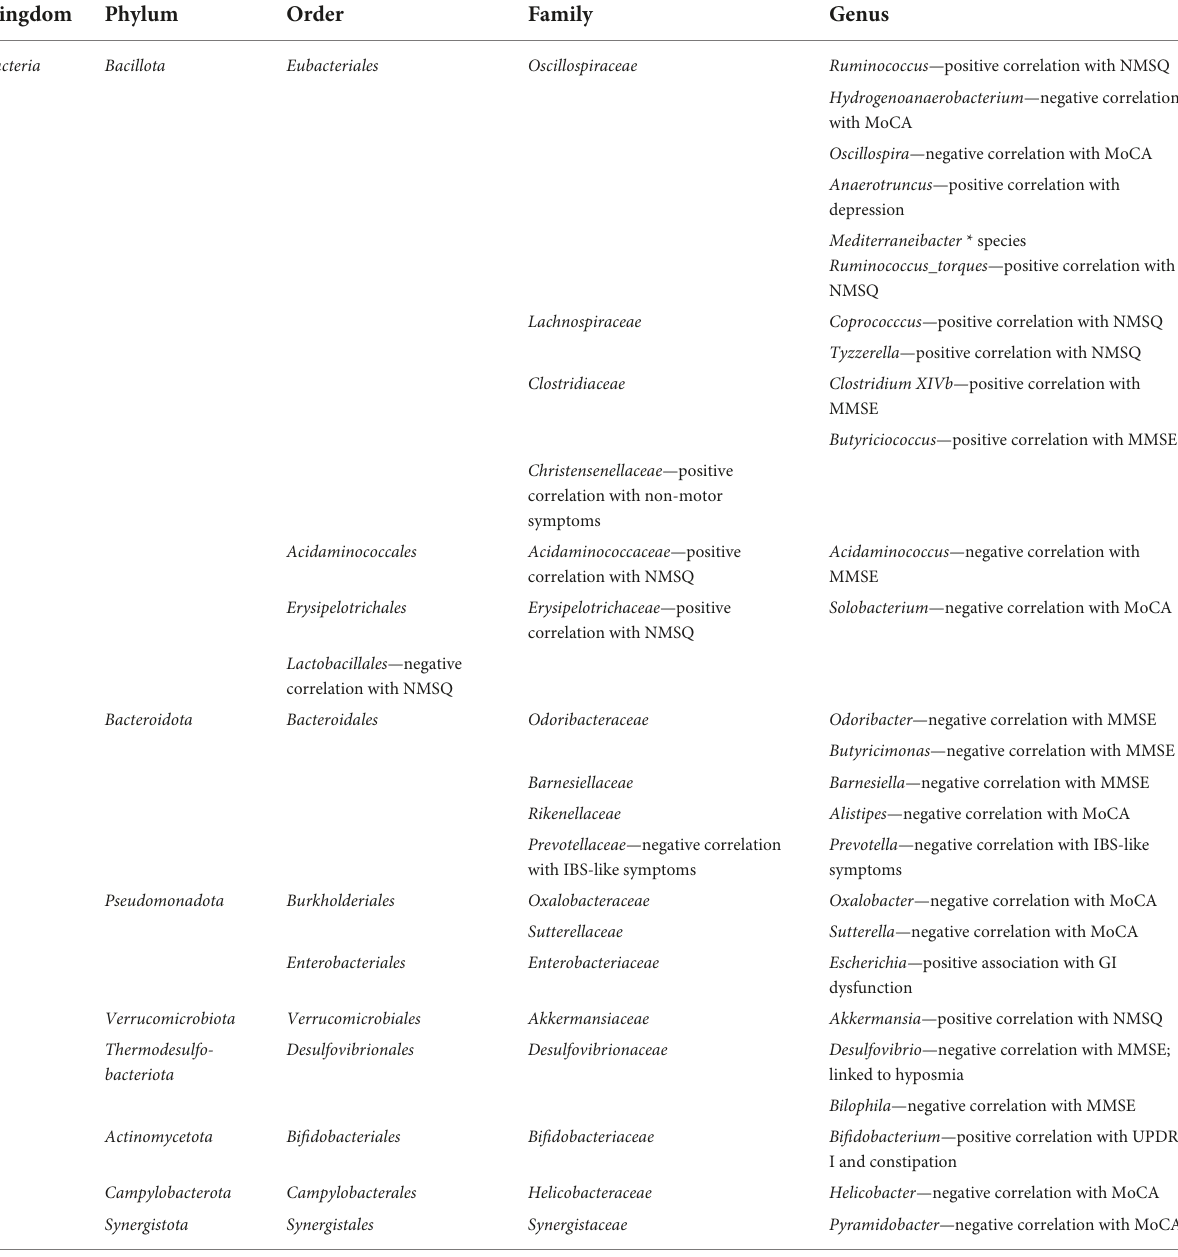
TABLE 4 Relative abundances of bacterial taxa in correlation with non-motor